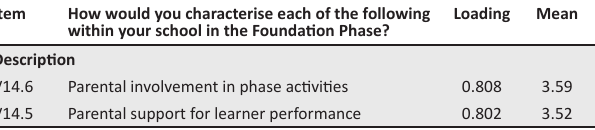
TABLE 8: The items, their loadings and mean scores contained in the factor ‘The parent’s motivation of learner performance in the Foundation Phase’.